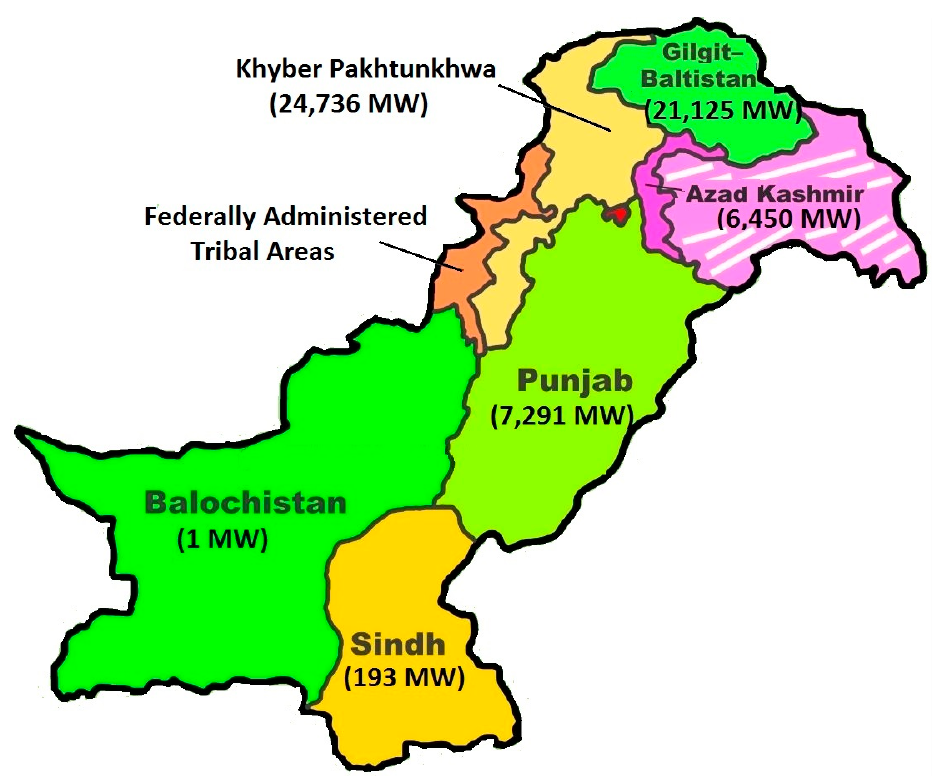
Figure 1. Pakistan’s hydropower potential (Pakistan’s map courtesy of OnTheWorldMap.com).